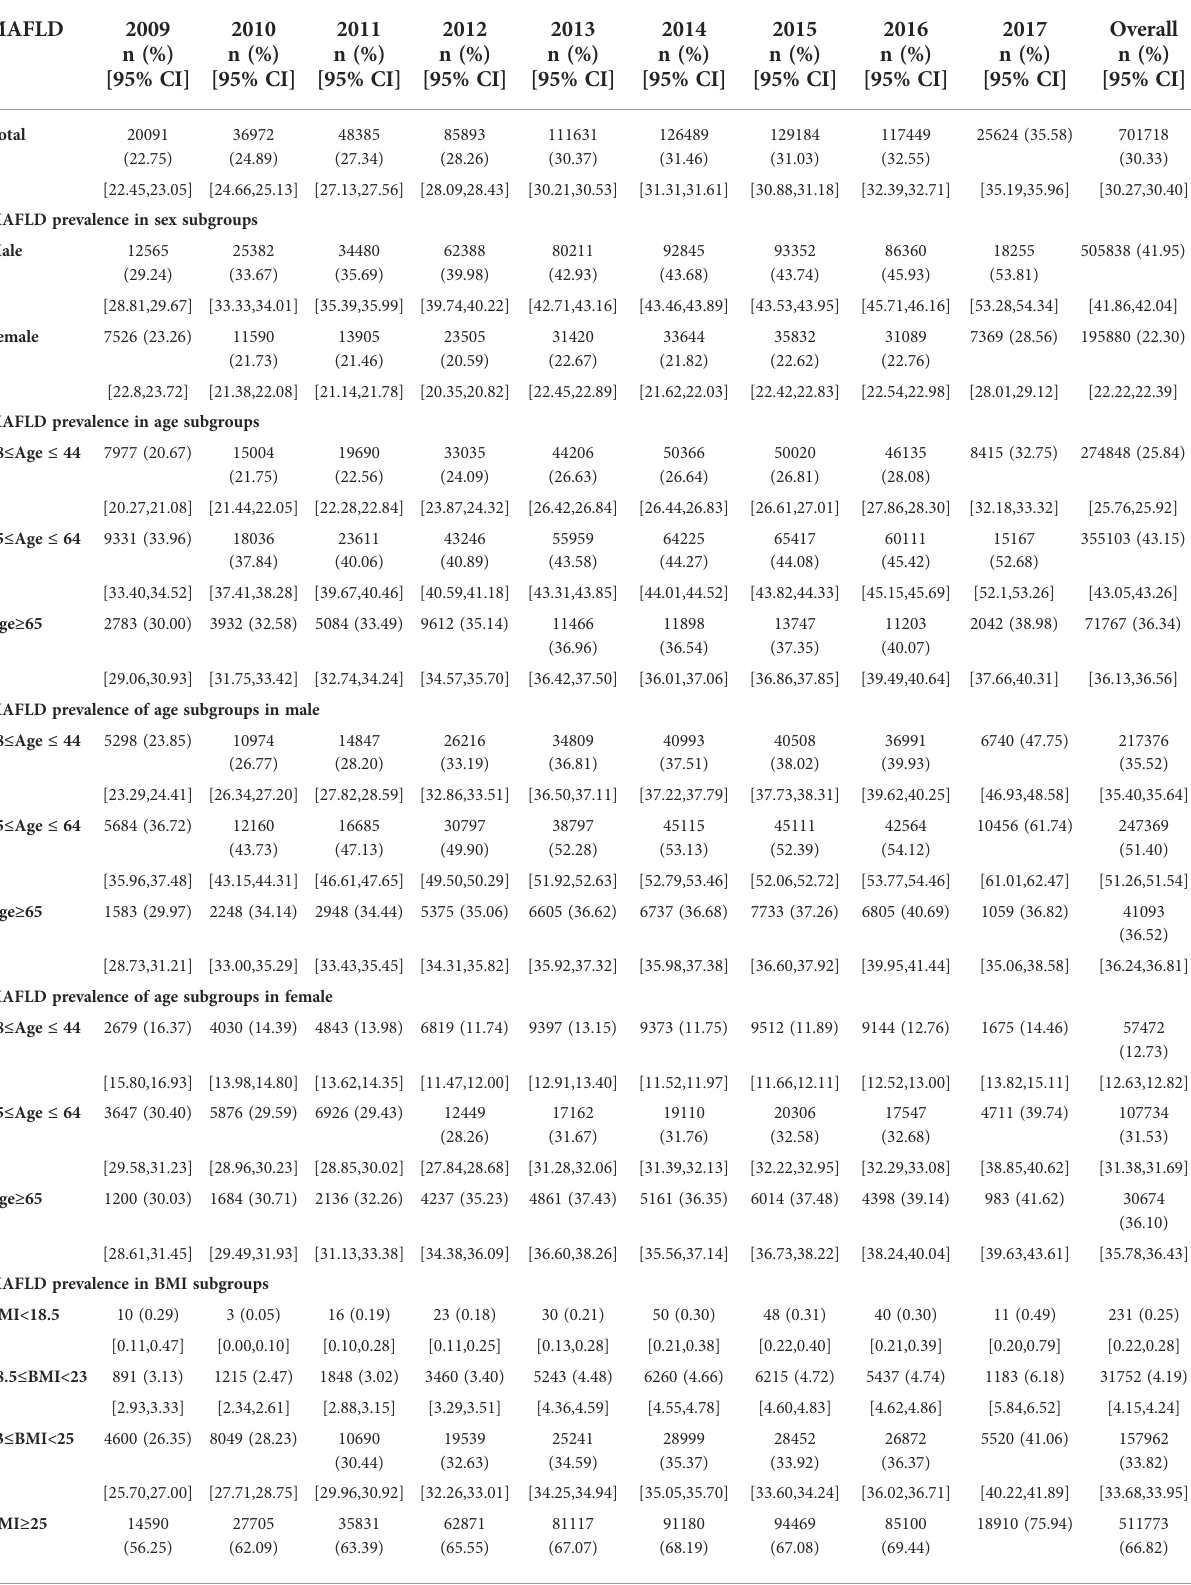
TABLE 3 Prevalence of Metabolic Dysfunction-Associated Fatty Liver Disease among Overall Participants and Subgroups from 2009-2017.